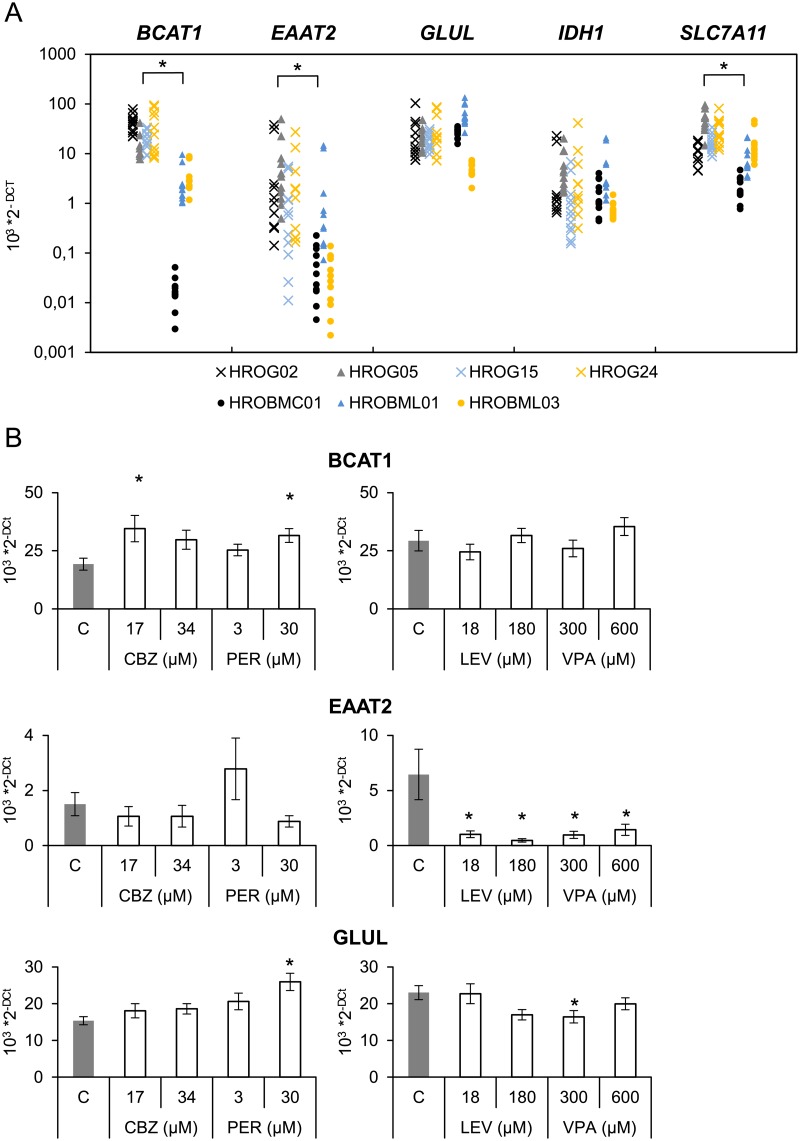
Effects of anticonvulsants on gene expression.Both, glioblastoma and metastasis cells were seeded in 12-well plates. On the next day, medium was exchanged and the cells were exposed to carbamazepine, levetiracetam, perampanel or valproic acid at the indicated doses for 48 h. Subsequently, the mRNA expression of the indicated genes and house-keeping control GAPDH was analyzed by real-time PCR. (A) Relative amounts (2-ΔCt) of target mRNA of control cultures were compared for both cell entities (n ≥ 10 per cell line), *p<0.05 versus glioblastoma cells (Mann-Whitney U test). (B) Furthermore, effects of anticonvulsants were analyzed. Only genes with significant changes are shown in Fig 4B (n = 5–6 separate cultures per cell line; *p<0.05 versus control cultures (Kruskal-Wallis test with post hoc Dunn’s test)).